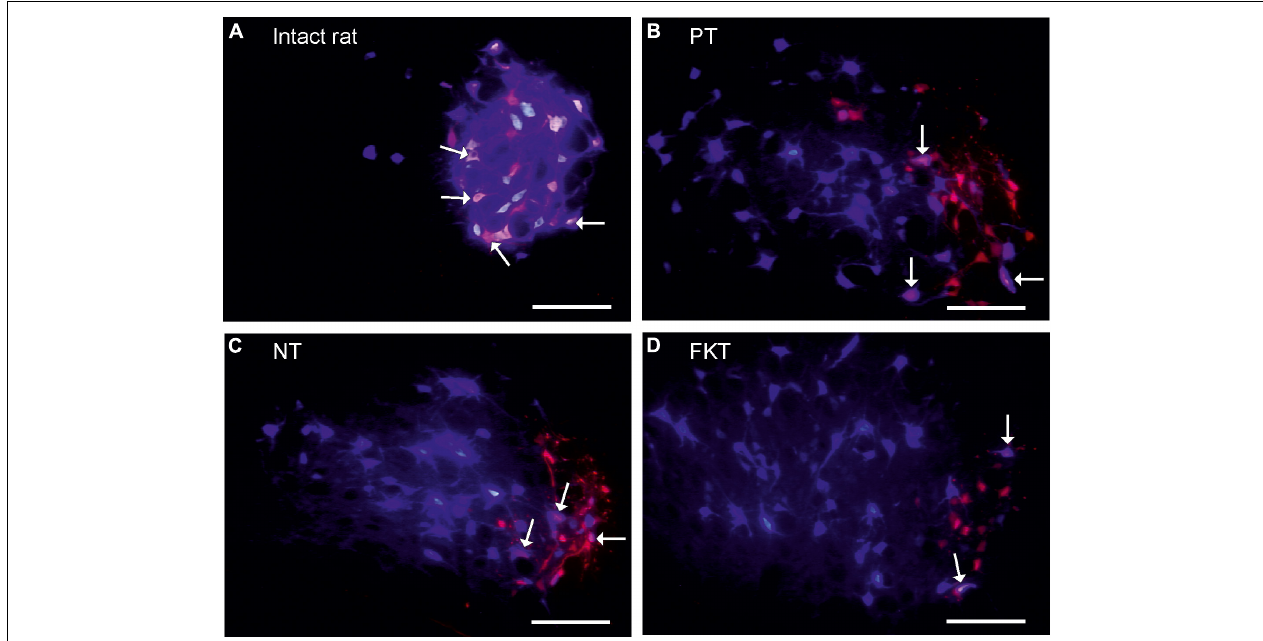
FIGURE 1 | Labeling of facial motoneurons. The original motoneurons of the lateral facial subnucleus that in normal anatomy innervate the vibrissae muscles, were retrogradely (pre)-labeled red by injection of Fluoro-Gold (FG) into the whisker pad. The regenerated motoneurons that innervate the whisker muscles following reinnervation were retrogradely post-labeled blue by injection of Fast Blue (FB) at the same site 56 days after facial nerve repair, 10 days prior to fixation All images addition of FG-selective filter + FB-selective filter from same field of view, primary magnification objective 10 × , Scale bar 100 µ m. (A) In intact rat, 94% of the motoneurons prelabeled with FG are double-labeled also with FB ( arrows ). This is the normal myotopic organization in the lateral facial subnucleus. (B) Implantation of an artificial nerve conduit (AC) into the facial nerve trunk, post-operative treatment with placebo (PT). On the operated side all preoperatively labeled facial motoneurons ( red ) are exclusively localized in the lateral facial subnucleus which is the normal myotopic distribution, but the post-operatively labeled motoneurons ( blue ), are scattered throughout the entire facial nucleus (except for the medial subnucleus) proving a complete loss of myotopic organization and severe misdirection of reinnervation. Only 38% motoneurons are double-labeled ( pink , arrows ). (C,D) Implantation of an artificial nerve conduit followed by systemic drug therapy with nimodipine (NT, C) or FK506 (FKT, D) for 56 days. About 40% of the neurons are double-labeled ( pink , arrows ). There is no difference in number and distribution pattern of labeled motoneurons to that of placebo-treated rats (B)